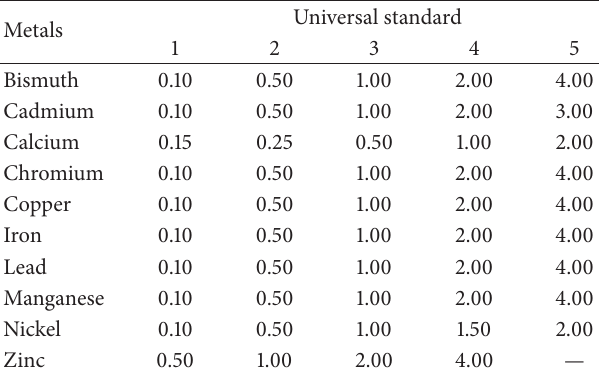
Table 2: Universal standards concentration (mg/L) for analyzed